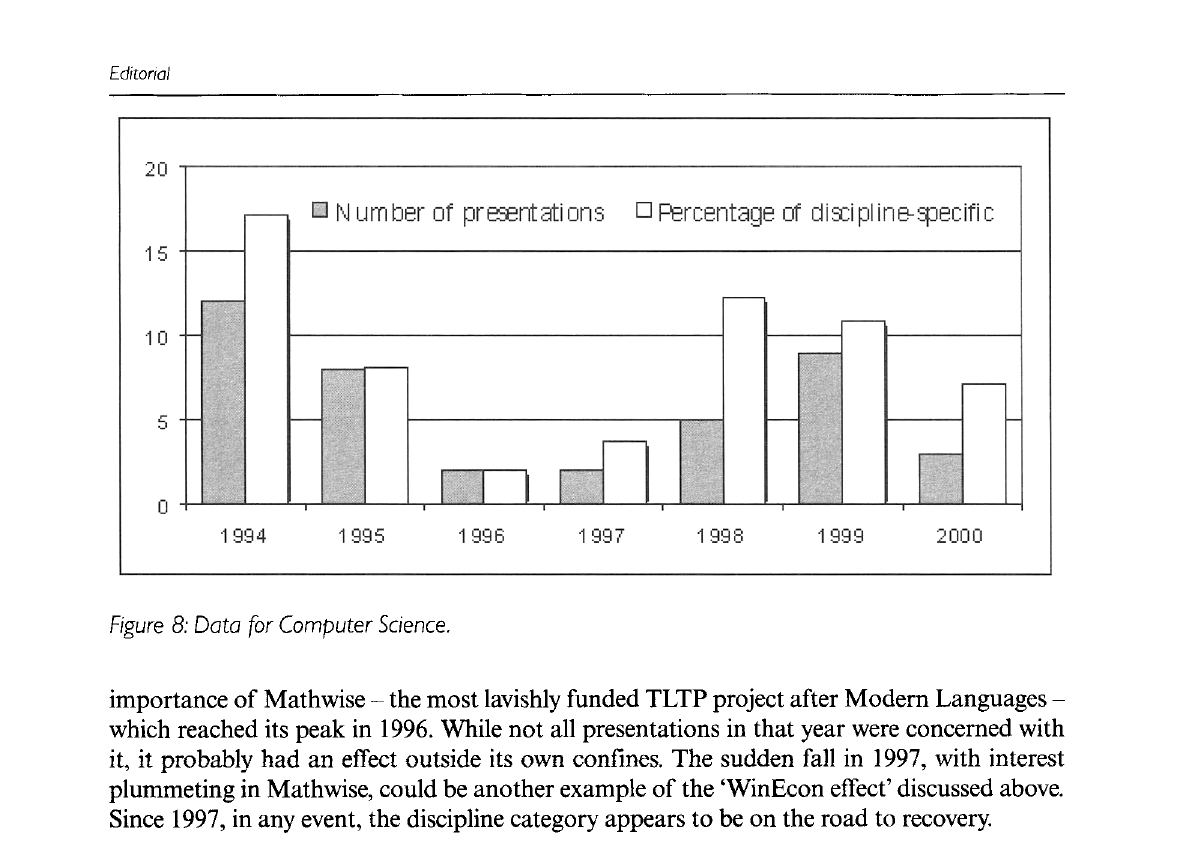
Figure 8: Data for Computer